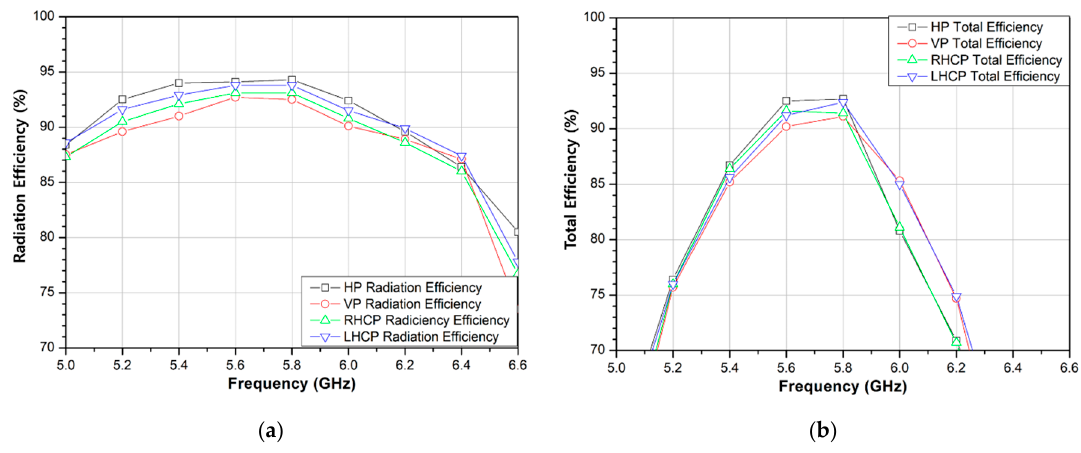
Figure 6. Simulated ( a ) radiation e ffi ciency and ( b ) total e ffi ciency over the operation